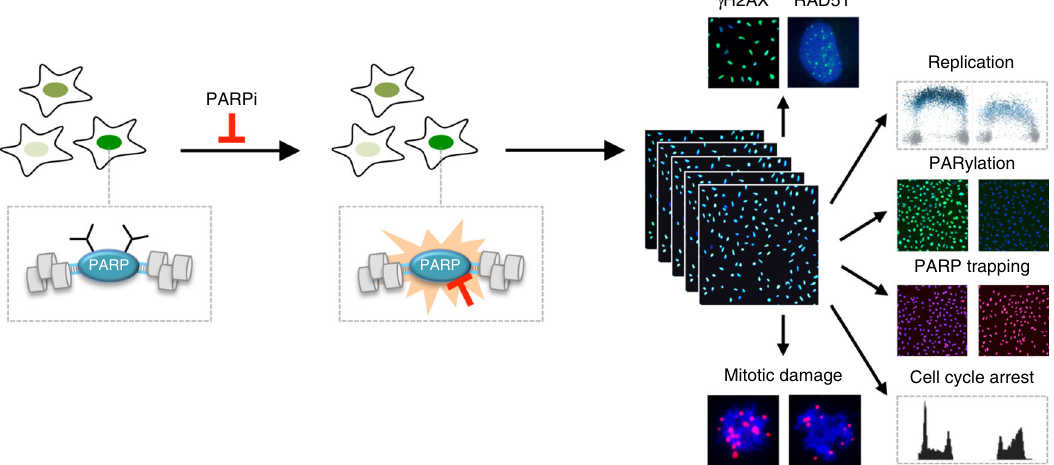
Fig. 8 Multidimensional analysis of PARPi toxicity by cell cycle resolved automated high-content microscopy. Key parameters of the cellular response to PARPi are simultaneously quanti fi ed, including DNA damage signaling (measured by γ H2AX formation), activation of the homologous recombination repair pathway (measured by RAD51 foci formation), slow-down of DNA replication (measured by EdU incorporation), inhibition of PARP enzymes (measured by changes in poly(ADP-ribose) (PAR) levels), trapping of PARPs (measured by PARP levels after in situ fractionation), cell cycle arrest (measured by accumulation of cells in speci fi c cell cycle phases), and mitotic chromosomal damage (measured by γ H2AX on mitotic chromosomes). The experimental pipeline is equally suited for individual assays and large scale high-throughput